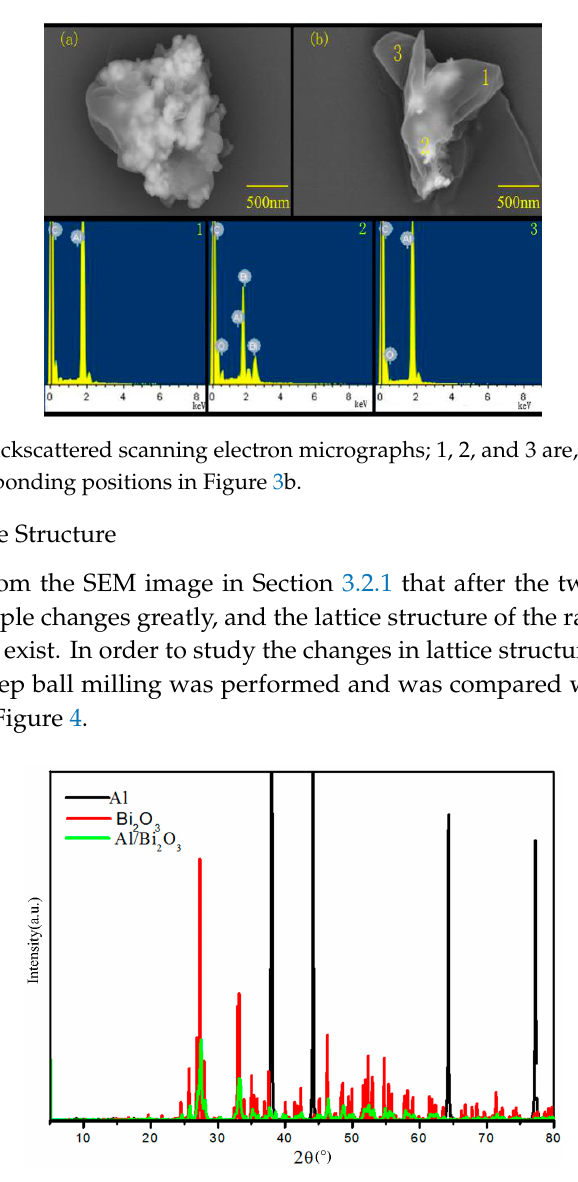
Figure 4. XRD comparison of raw materials and ball-milled samples.